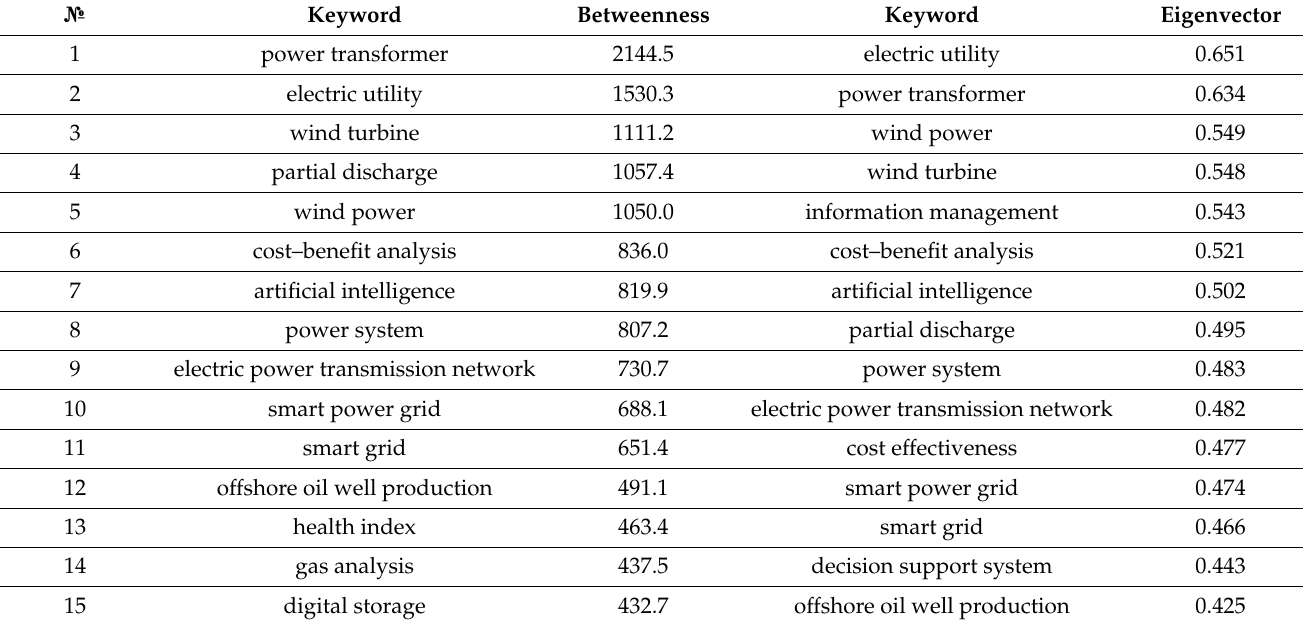
Table 1. Top-15 keywords by Betweenness centrality and Eigenvector centrality values.